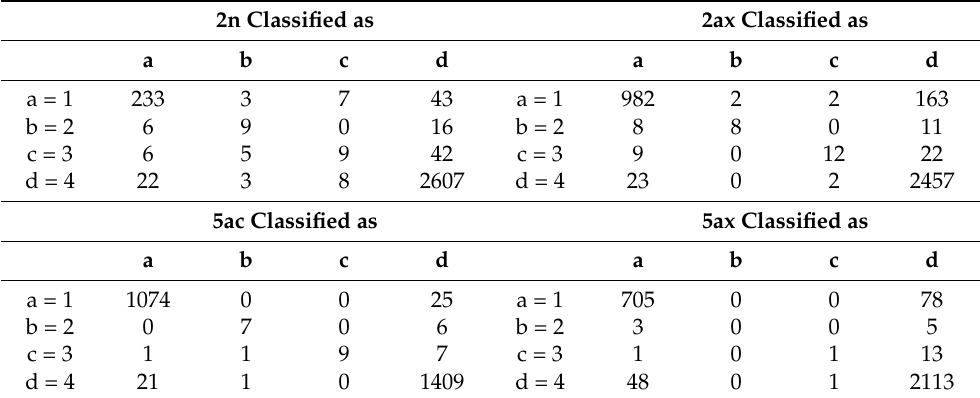
Table 2. Confusion matrix of REPTree models produced for 2n, 2ax, 5ac and 5ax datasets. 2n Classified as